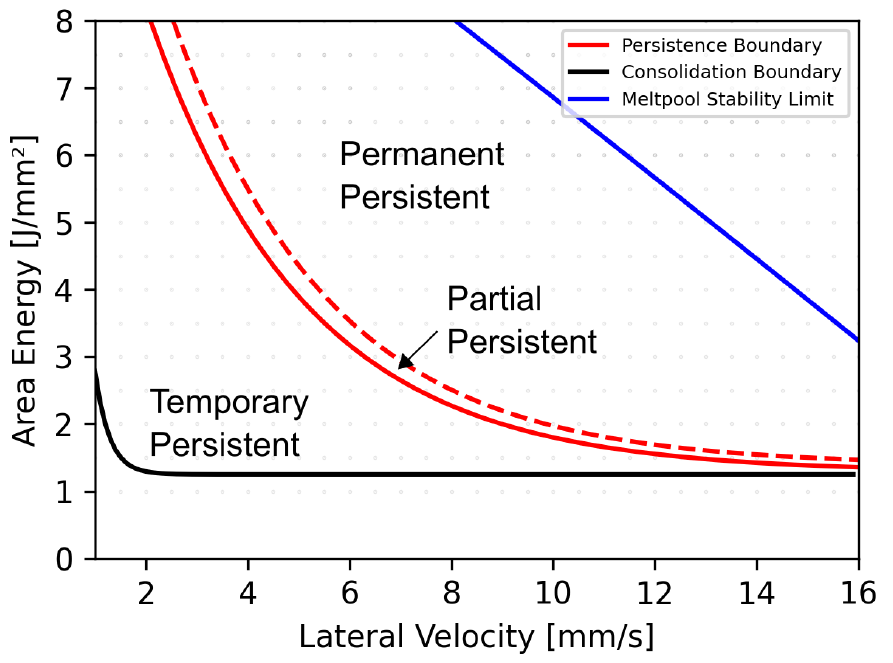
Figure 8. Simulated melt pool geometries in the stationary state of 512 process parameter combina- tions (gray) and respective processing boundaries of quadratic CMSX-4 samples with a side length of 15mm and constant line offset of 100 µ m, with a preheating temperature of 1020°C. The consolidation boundary (black) is defined by melt pools exceeding the effective layer thickness of (100 µ m) [14]. The persistence boundary (red) is defined by the onset on a permanent persistent melt pool, which increases in size within the transition region until the permanent persistent region covers the complete sample (red stripes). The melt pool stability limit is reached when the ratio of lateral extension to melt pool depth reaches a critical limit of